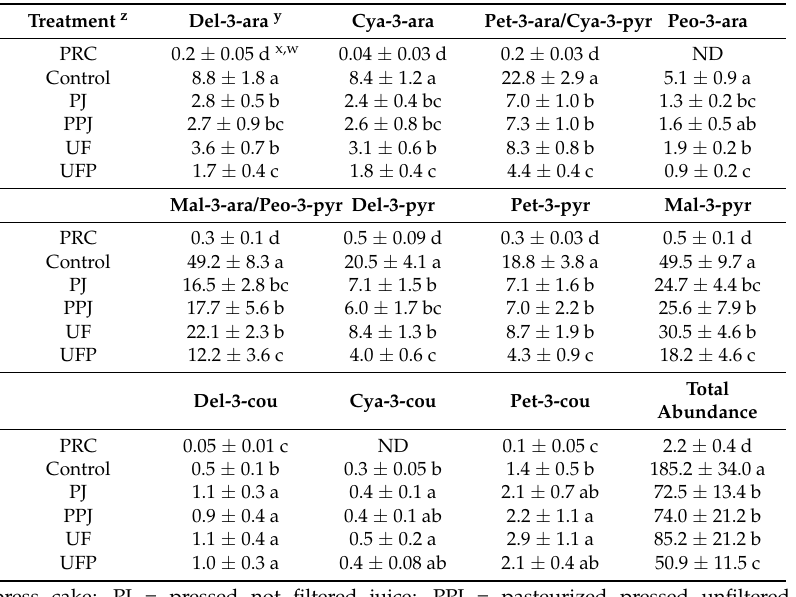
Table 3. Average semi-quantitative LC–MS/MS anthocyanin peak area abundance in rabbiteye blueberry during various processing